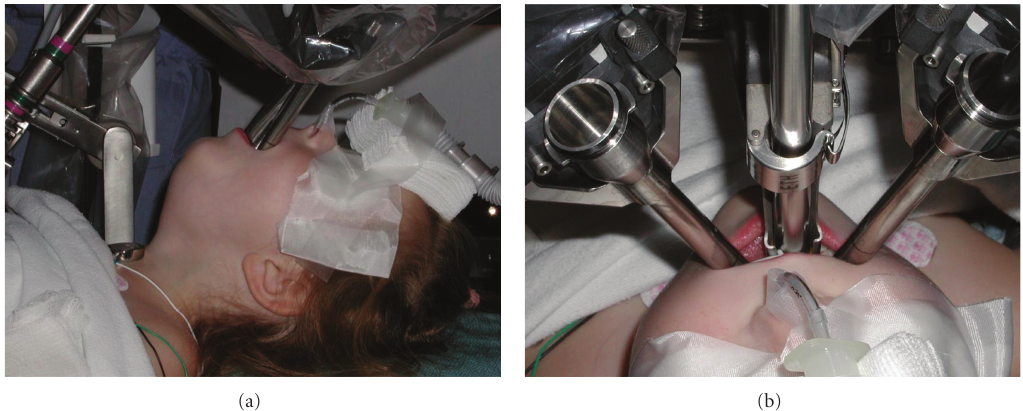
Figure 3: Robotic arms positioning in the oral cavity. Laryngeal reconstruction in pediatric patient. (Courtesy of Dr. Rahbar,